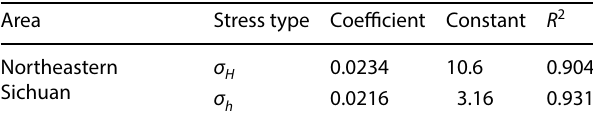
Table 1 Regression coefficients of horizontal principal in situ stress in the northeastern of Sichuan Area